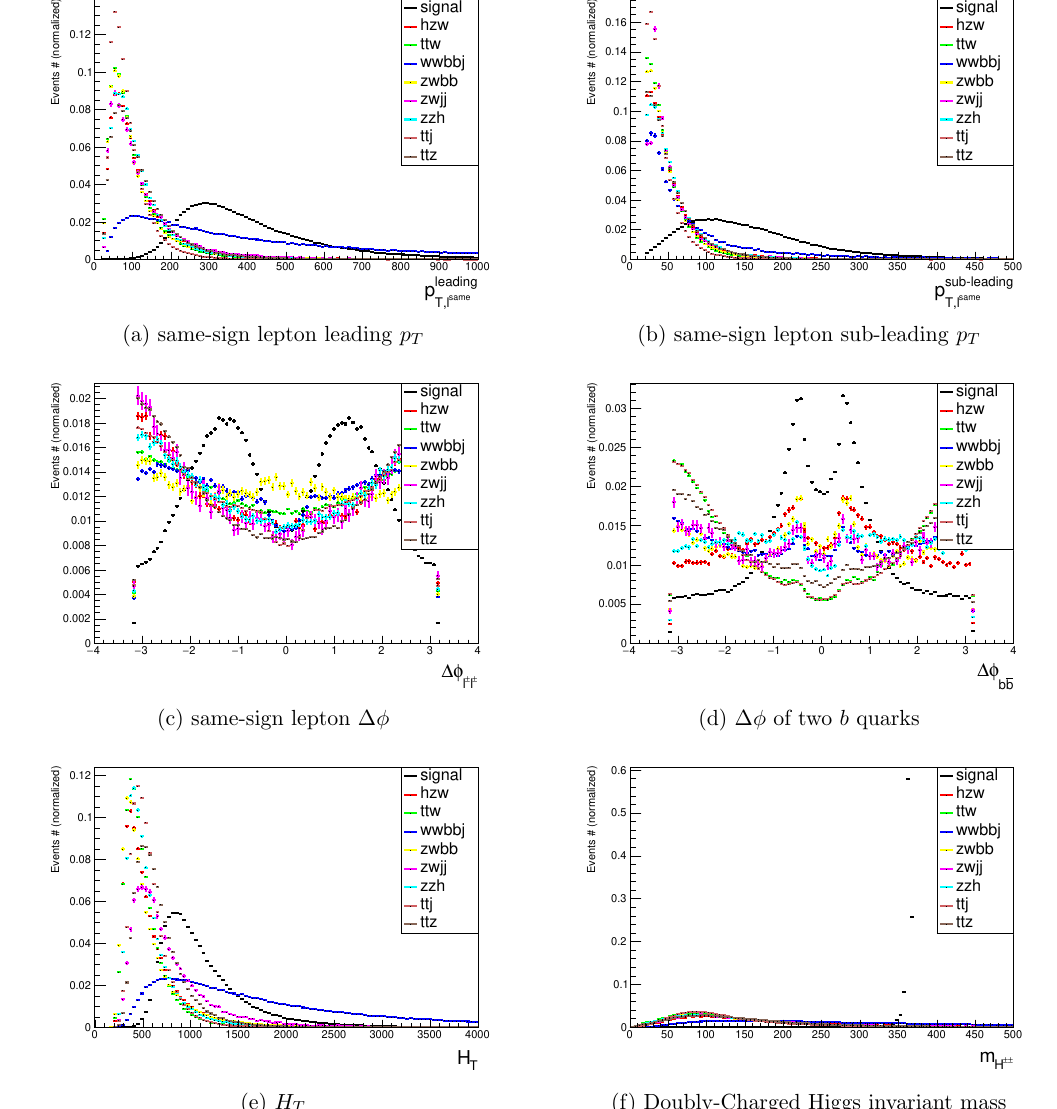
Figure 9 . Representative reconstructed variables for the ‘ (cid:6) ‘ (cid:6) hW (cid:7) channel after the basic cuts. We use the word \signal" to represent the pp ! H (cid:6)(cid:6) H (cid:7) ! ‘ (cid:6) ‘ (cid:6) hW (cid:7) channel in all histograms